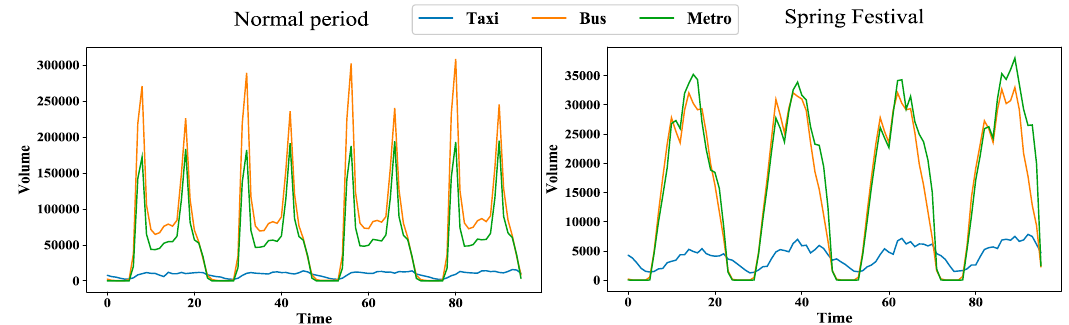
Figure 2. The hourly volume of the three ridership modes over different periods.